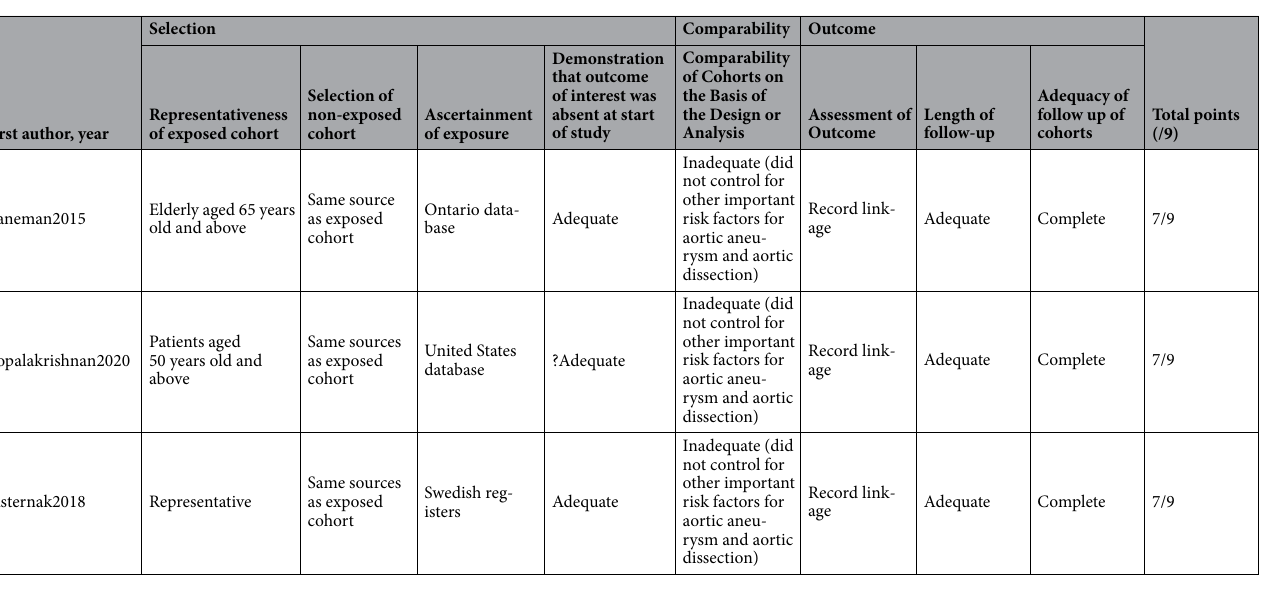
Table 4. Risk of bias assessment for cohort